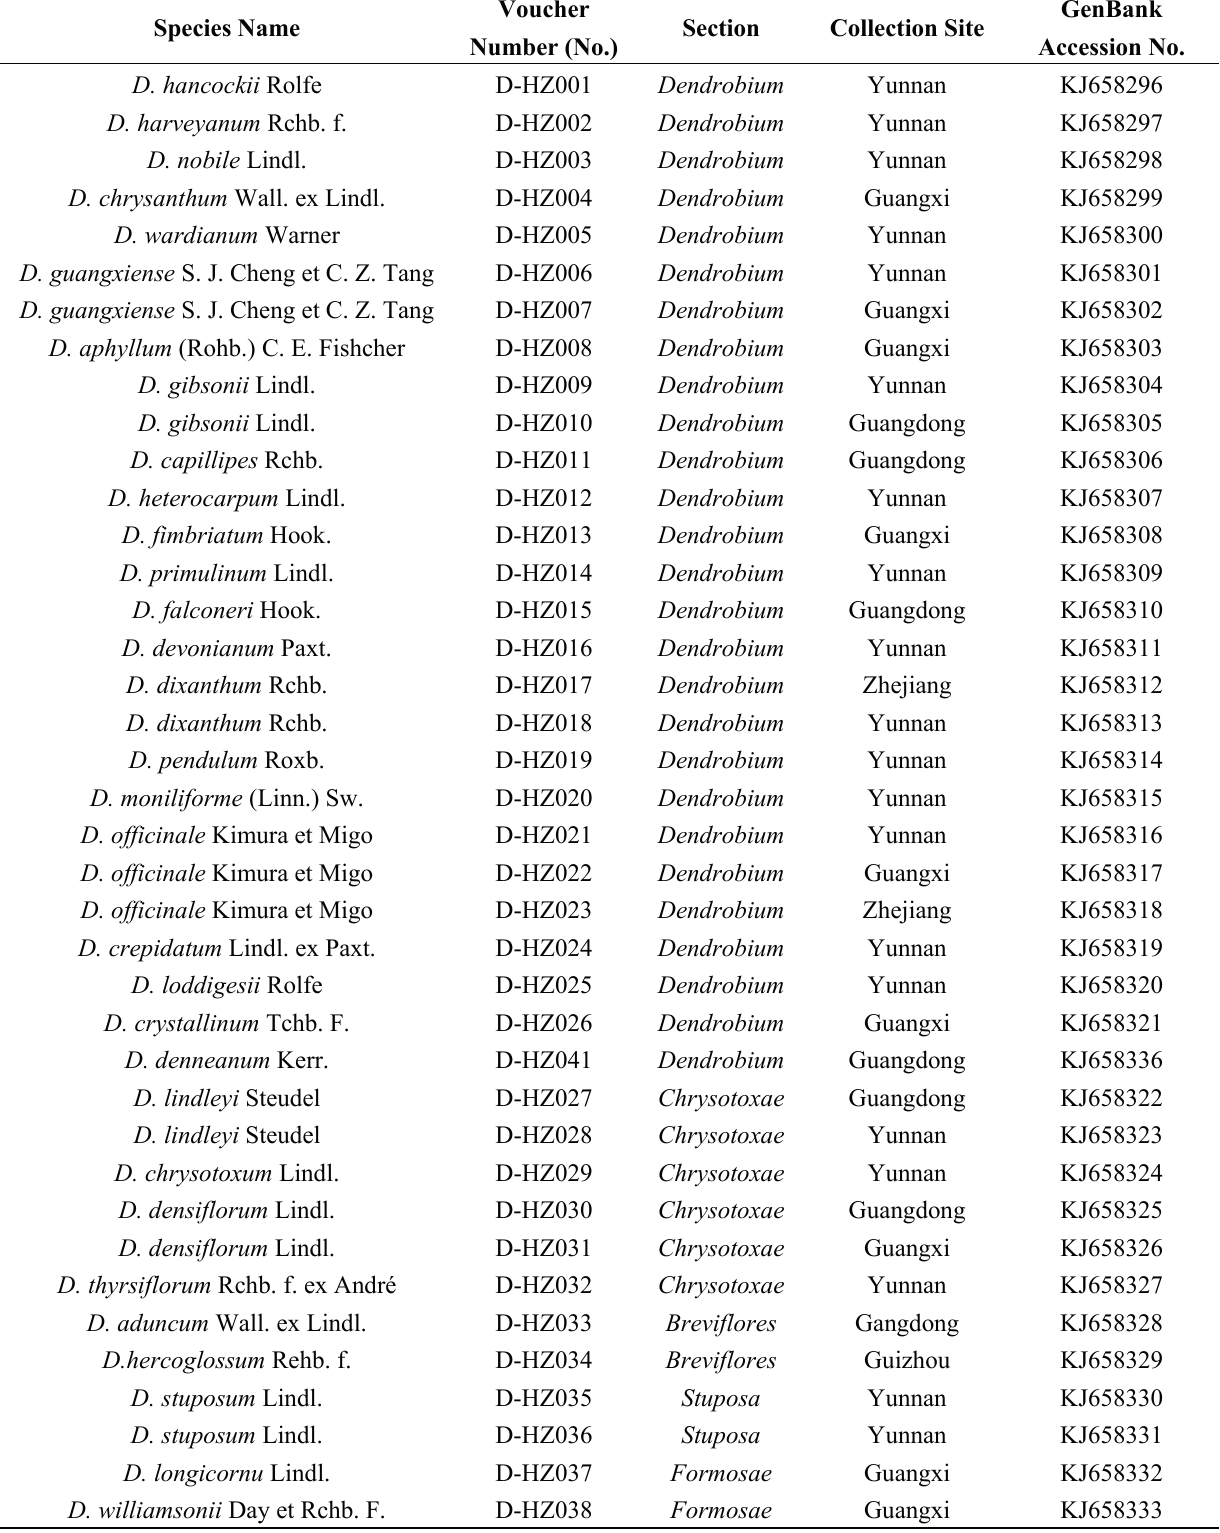
Table 3. Plant samples of Dendrobium used for analysis in this study with voucher number (No.) and GenBank Accession